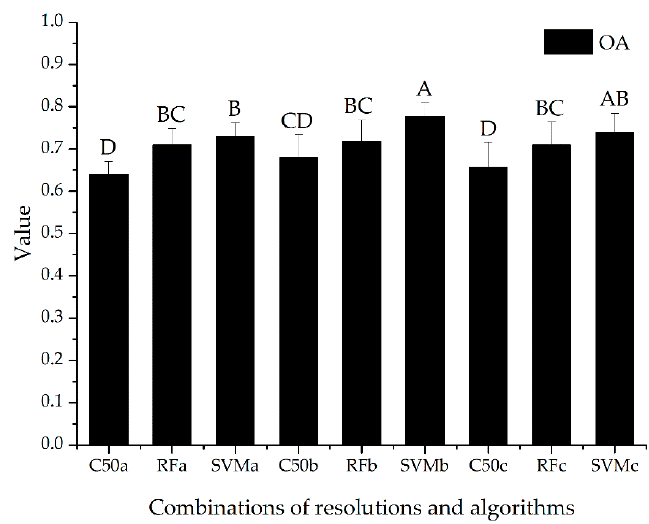
Figure 4. Overall accuracy (OA) of classification for different combinations of resolutions and algorithms using GF2 images, for which the significance level was 0.05. a: 1 m resolution images based on the object method; b: 1 m resolution images based on the pixel method; c: 4 m resolution images. Error bars indicate the standard deviations of 10 classifications. A–D: pairwise differences among combinations of resolutions and algorithms in the classification performance.